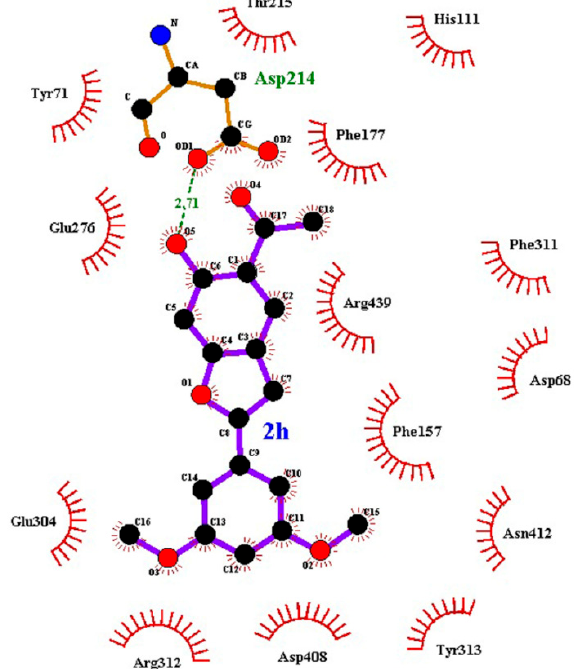
Figure 6. The details interactions of compound 2h at the binding site of built structure of α - glucosidase.